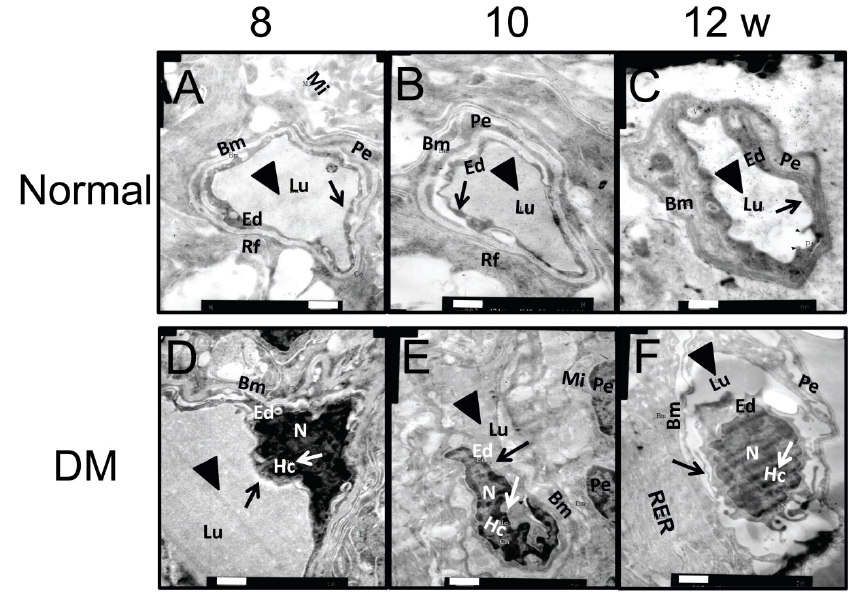
Figure 2. Ultrastructures of retinal microvessels in STZ-induced diabetic rats. The ultrastructures of retinal microvessels in normal ( A – C ) and DM rats ( D – F ) were examined by TEM at weeks 8, 10, and 12 following diabetic induction. Representative pictures are shown ( n = 5). Black triangles refer to capillary lumen, black arrows refer to endothelial cells, and white arrows indicate heterochromatin. Bm: Basement membrane, Lu: capillary lumen, Ed: endothelial cell; Pe: pericyte; Mi: mitochondria, Rf: reticular fiber, N: nucleus, Hc: heterochromatin, RER: rough endoplasmic reticulum. Scale bar = 500 nm.